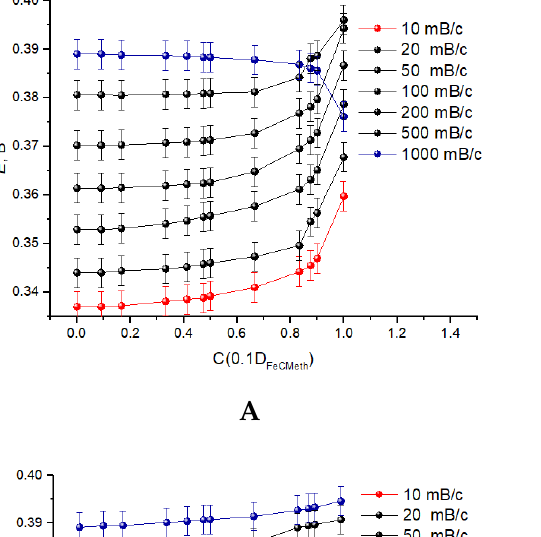
Figure 21. Color diagrams of the near-electrode area concentration at the moment of reaching the end of the first branch of the voltammetric waveform for sweep speeds of 100 ( A ) and 1000 ( B ) mV/s.